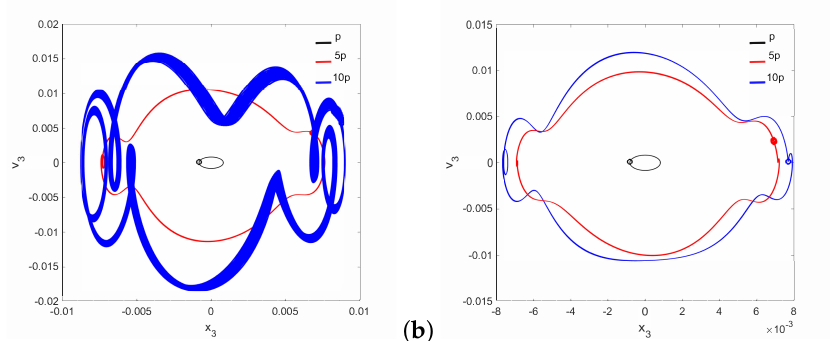
Figure 11. Phase diagrams of the stapes motion in the pathological ear for γ 24 = 1 × 10 5 ( a ) and γ 24 = 2 × 10 6 ( b